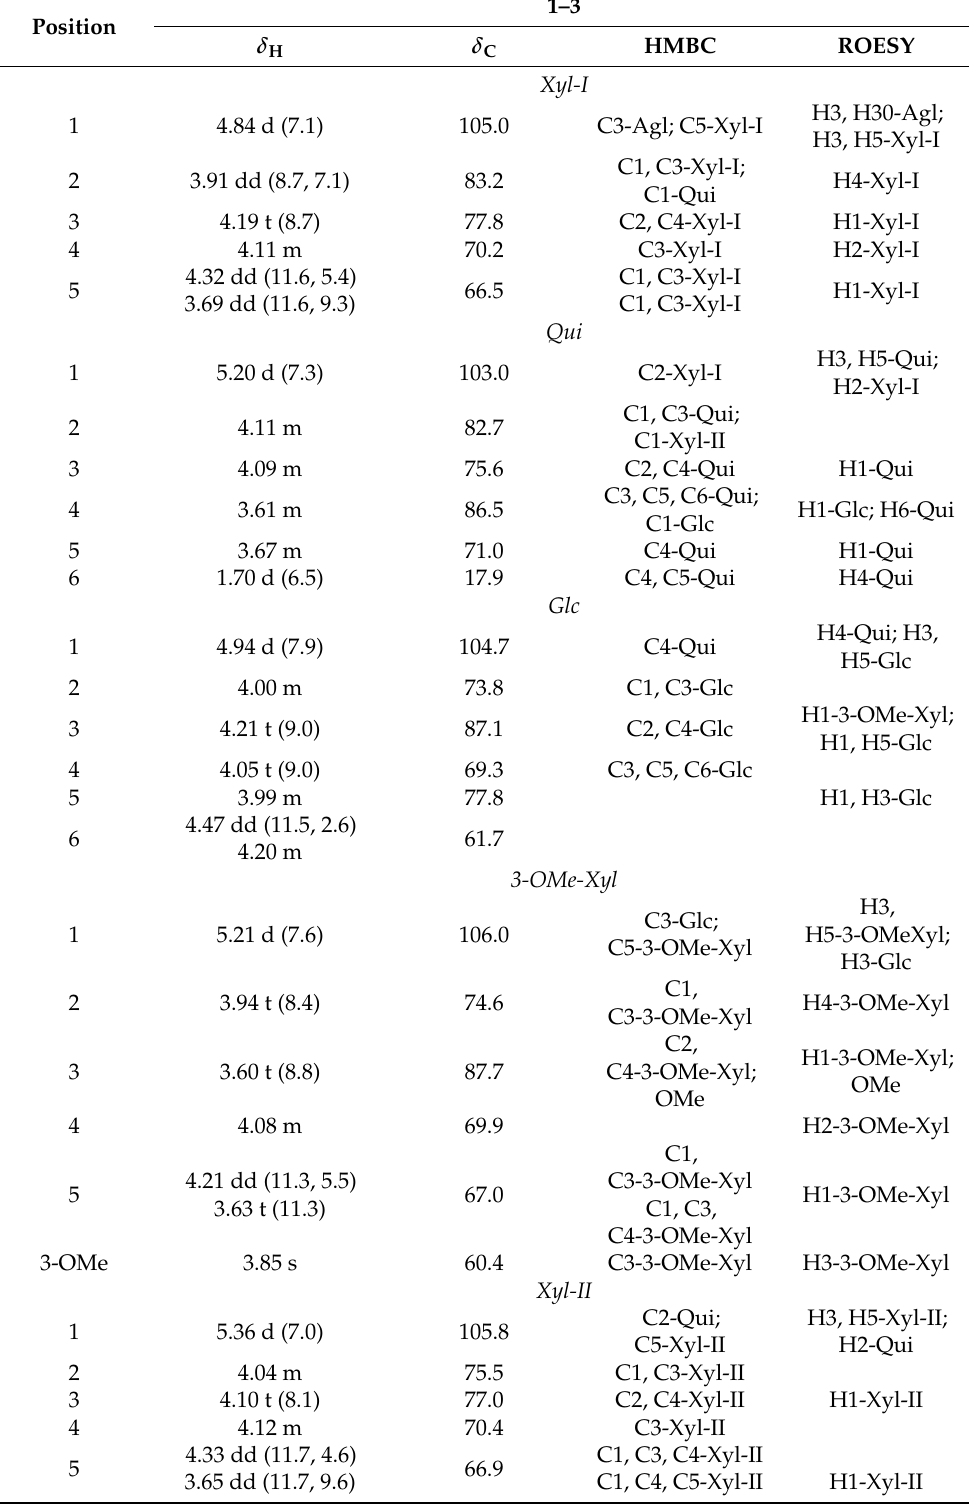
Table 2. 1 H, 13 C, HMBC, and ROESY NMR data of oligosaccharide chains of 1–3 (35 ◦ C, C 5 D 5 N, J in Hz) a